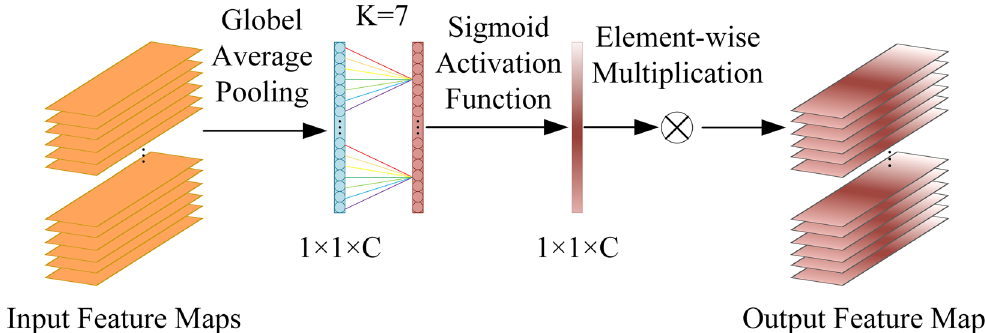
Figure 2. The structure of the ECA module.